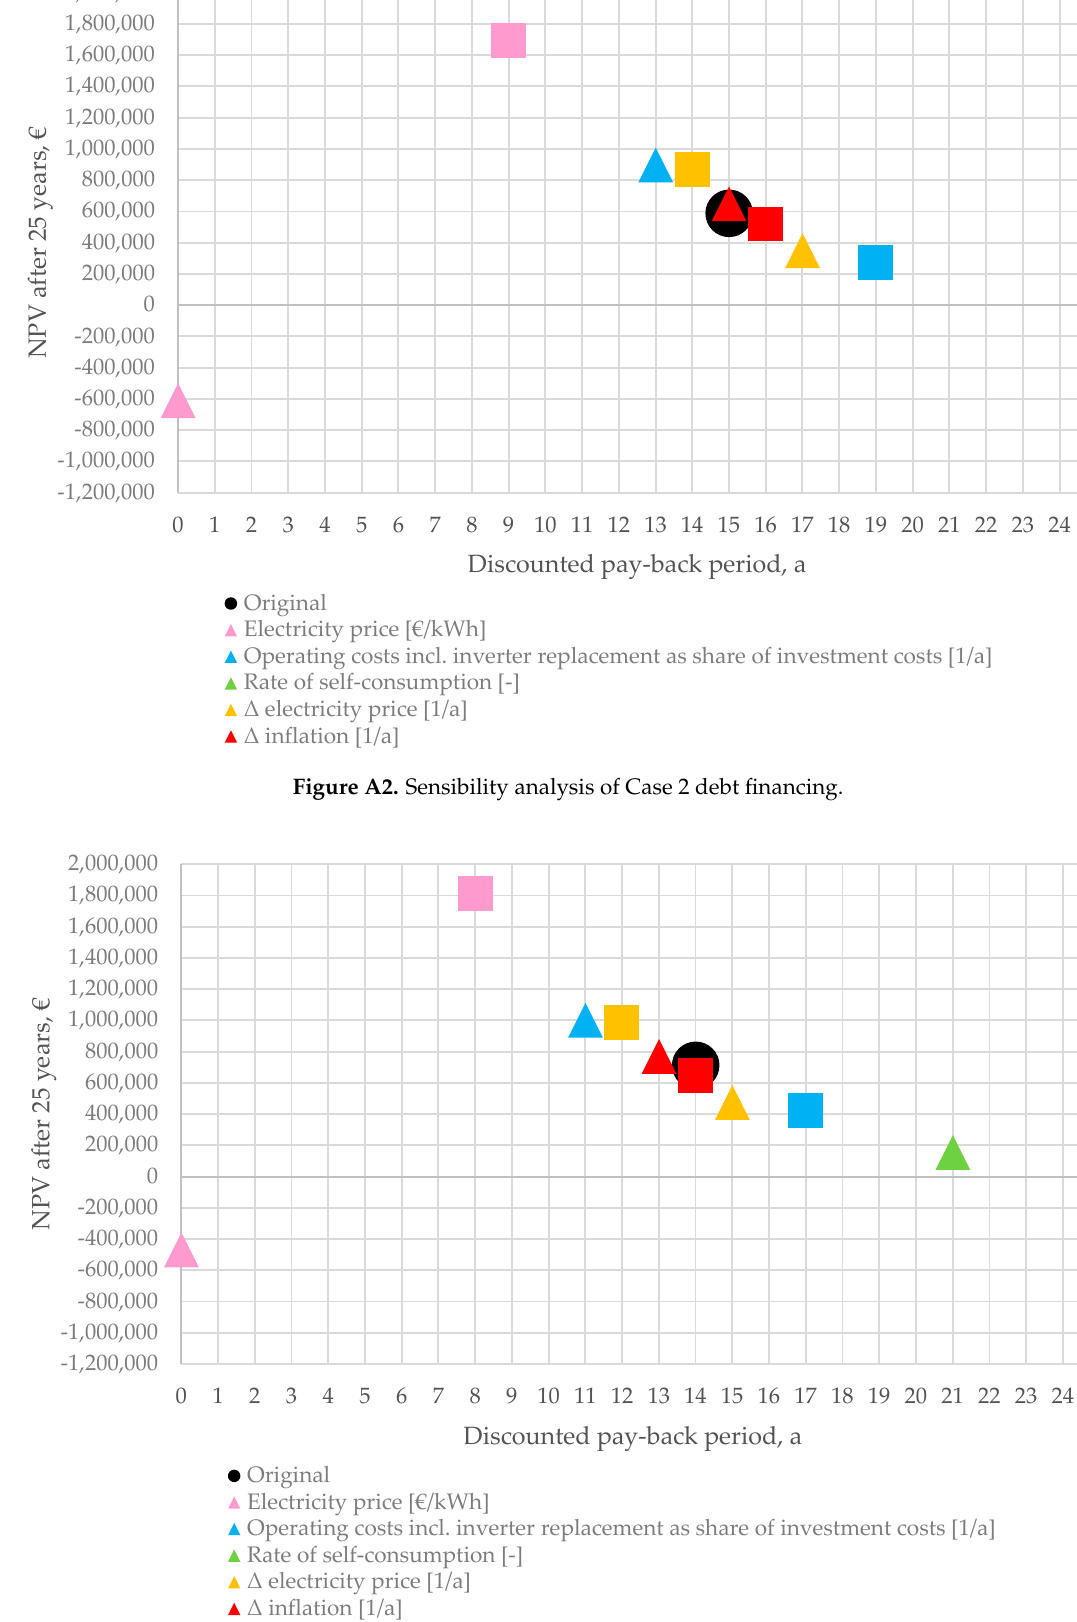
Figure A3. Sensibility analysis of Case 3 debt financing.